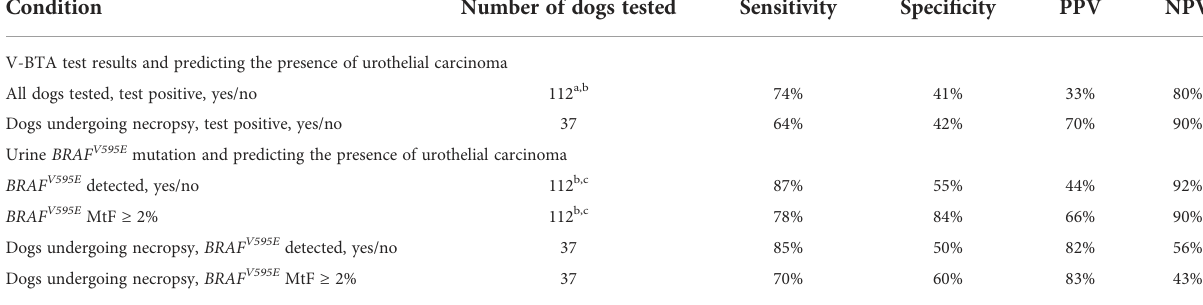
TABLE 6 Summary of fi ndings from exploratory molecularly-based urine tests including a Veterinary-Bladder Tumor Antigen Test (V-BTA) (52) and a ddPCR assay to detect the presence of the BRAF V595E mutation (36, 37).